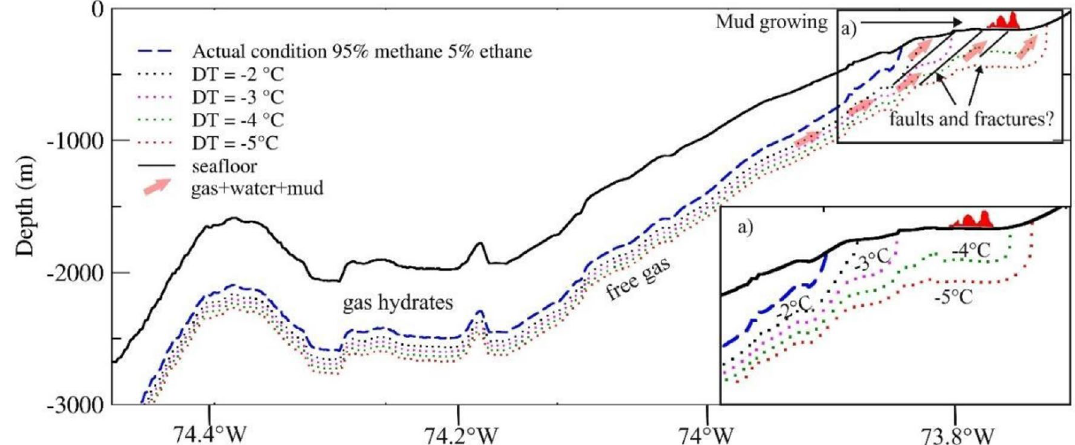
Figure 8. Schematic profile explaining mud growing formation (in red). The profile location is shown in Fig. 1. Dashed lines show theoretical bases of GHSZ by using the geothermal gradient of 30 °C/km for several scenarios supposing that the hydrate is formed by a mixture of 95% methane and 5% ethane. The blue dashed line indicates the actual theoretical base of the GHSZ. The dotted lines indicate the theoretical base of GHSZ supposing a decrease of the bottom temperature of 2 °C (black dotted line), 3 °C (magenta dotted line), 4 °C (green dotted line) and 5 °C (red dotted line). The solid black line indicates the seafloor. The pink arrows indicate the direction of the fluid/mud outflow. Possible faults and fractures are also reported as black lines. The rectangle in (a) shows the zoom, in which the modelling for the theoretical base of GHSZ reaches the continental